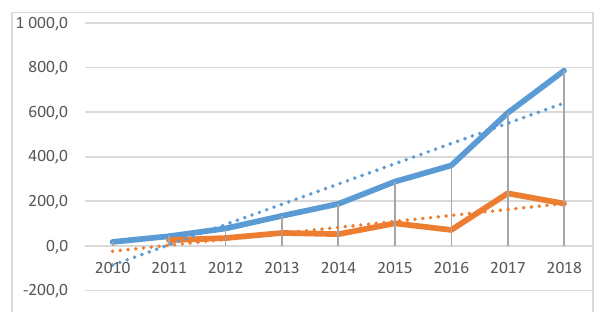
Figure 2. The total size of shape file and its yearly increase rates from 2010 to 2018. Blue represents the database size, orange the yearly increase